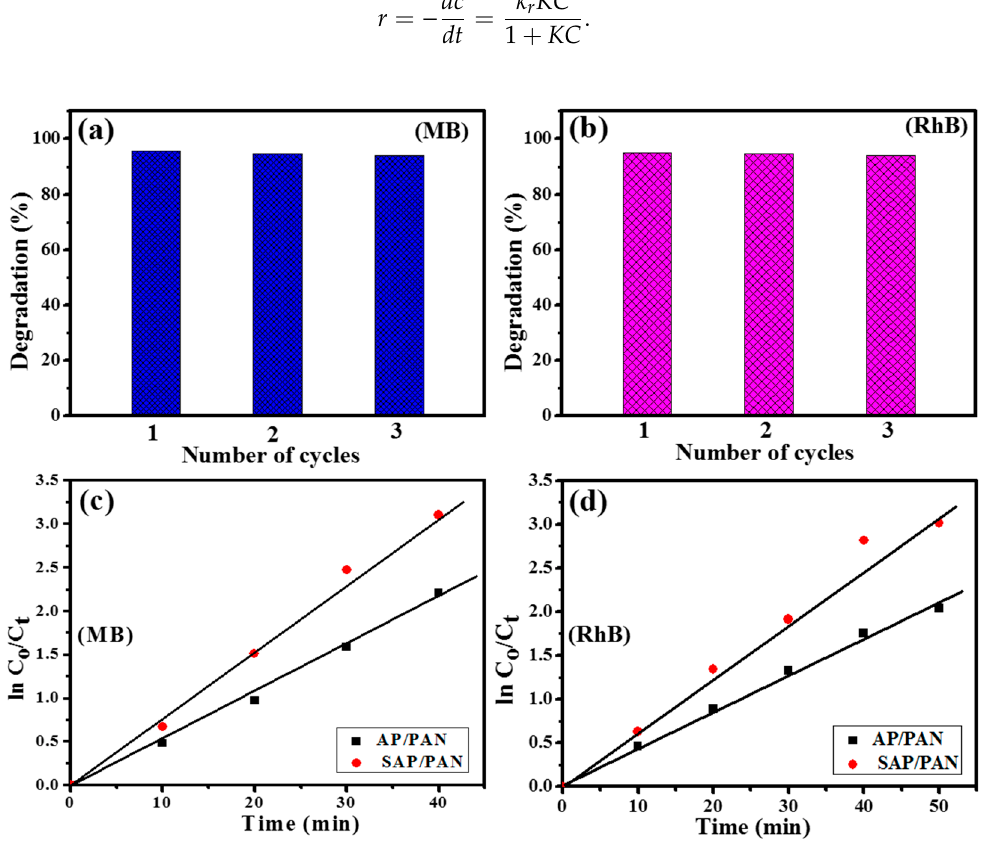
Figure 9. Cycling experiments of photodegradation of MB ( a ) and RhB ( b ) solutions utilizing SAP/PAN. Photodegradation Kinetics of MB ( c ) and RhB ( d ) solutions over different photocatalysts under visible light irradiation.